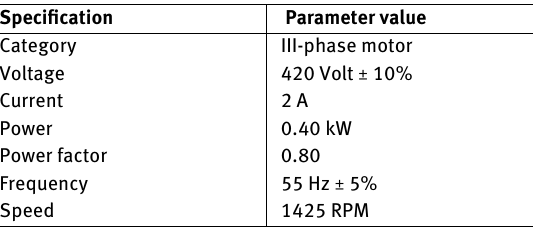
Table 1: Specifications of motor in